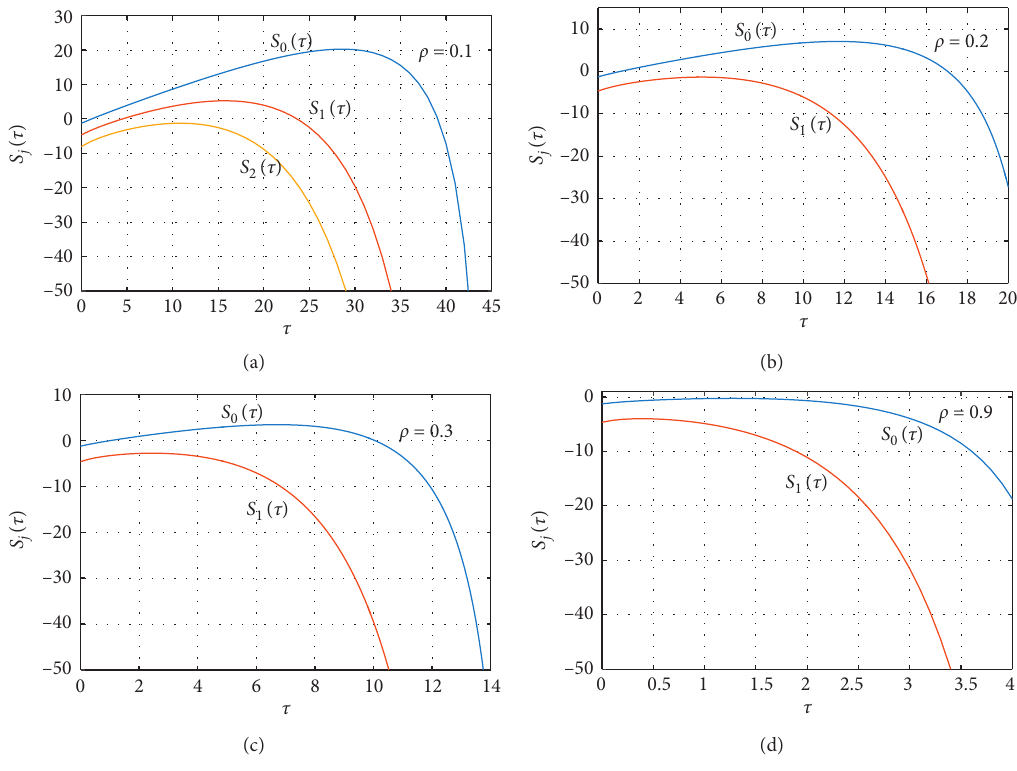
Figure 8: The effect of parameter ρ on the stability of